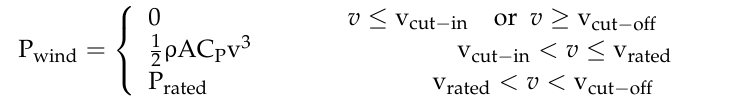
Figure 1. Weibull probability distribution function.